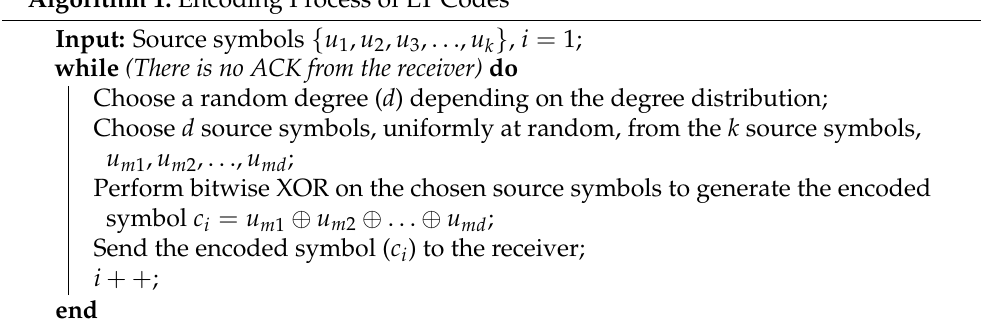
Algorithm 1: Encoding Process of LT Codes